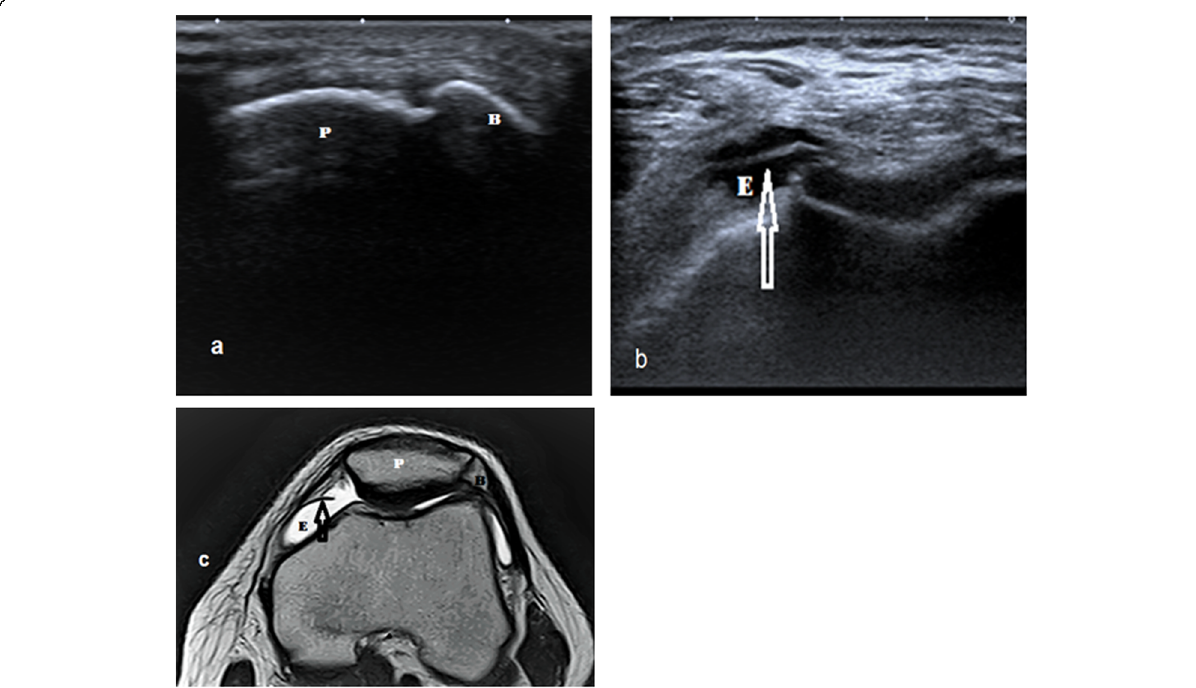
Fig. 7 A 31-year-old male with a bipartite patella, joint effusion, and medial patellar plica. a Short axis ultrasound image illustrates the cleft between the patella and bipartite fragment at the superolateral pole of the patella. b Short axis ultrasound image illustrates joint effusion and medial patellar plica (arrow). c Axial T2WI MRI illustrates bipartite patella, joint effusion, and medial patellar plica. P, patella; E, effusion; B, bipartite patellar